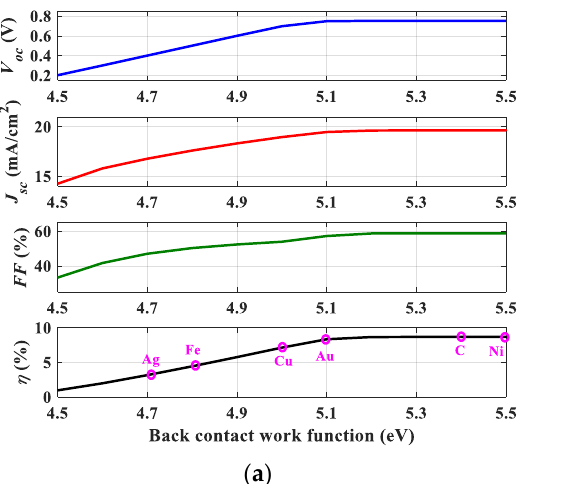
( b ) Figure 13. ( a ) Impact of p-layer doping variation on the HTL-free configuration photovoltaic parameters for two values of n-layer doping, and ( b ) recombination rates for three different values of p-layer doping. 3.2.2. Influence of Back Metal Work Function In this subsection, different metal contacts with distinct work function values are ex- amined. From Figure 14a, it is clear that optimum performance occurs by using the car- bon-based contact at 5.4 eV, which also satisfies the flat band condition. For work function values lower than 5.1 eV, the performance is deteriorated. Therefore, it is recommended